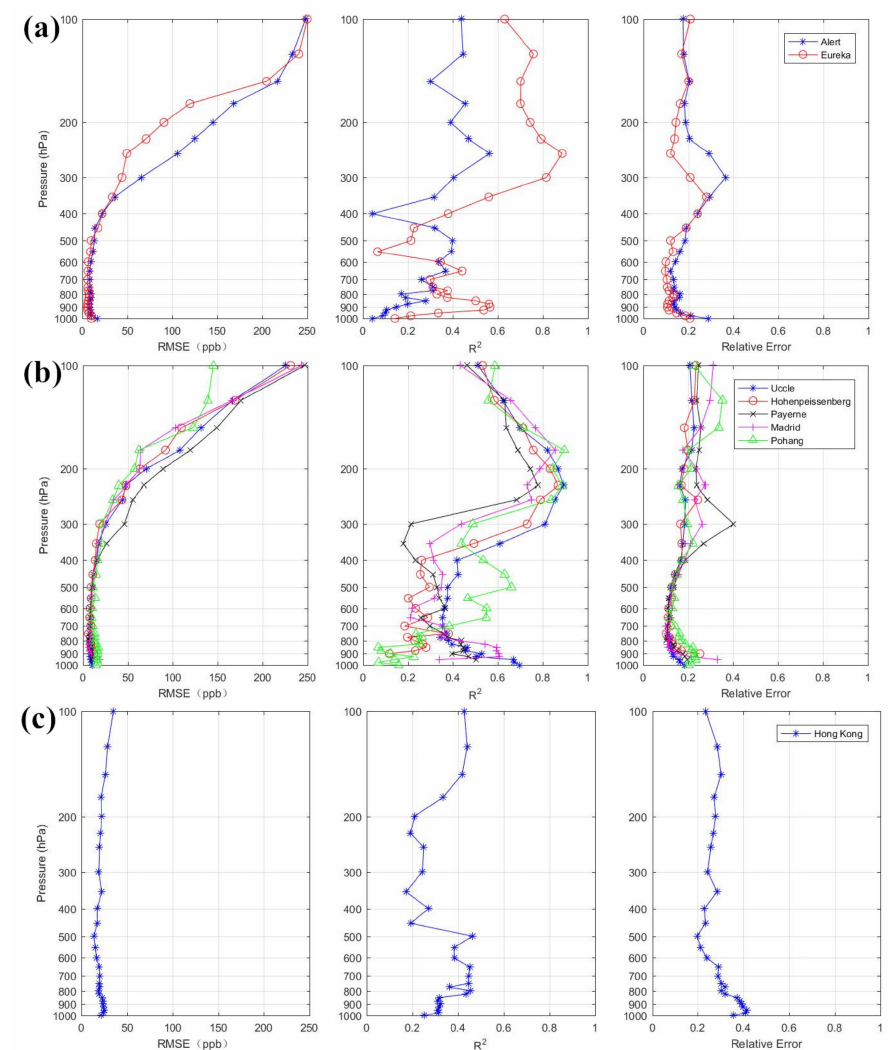
Figure 8. RMSE, R 2 , and RD stratification of tropospheric ozone on the test sets at WOUDC stations since 2019 for ( a ) NH, ( b ) NM, and ( c )